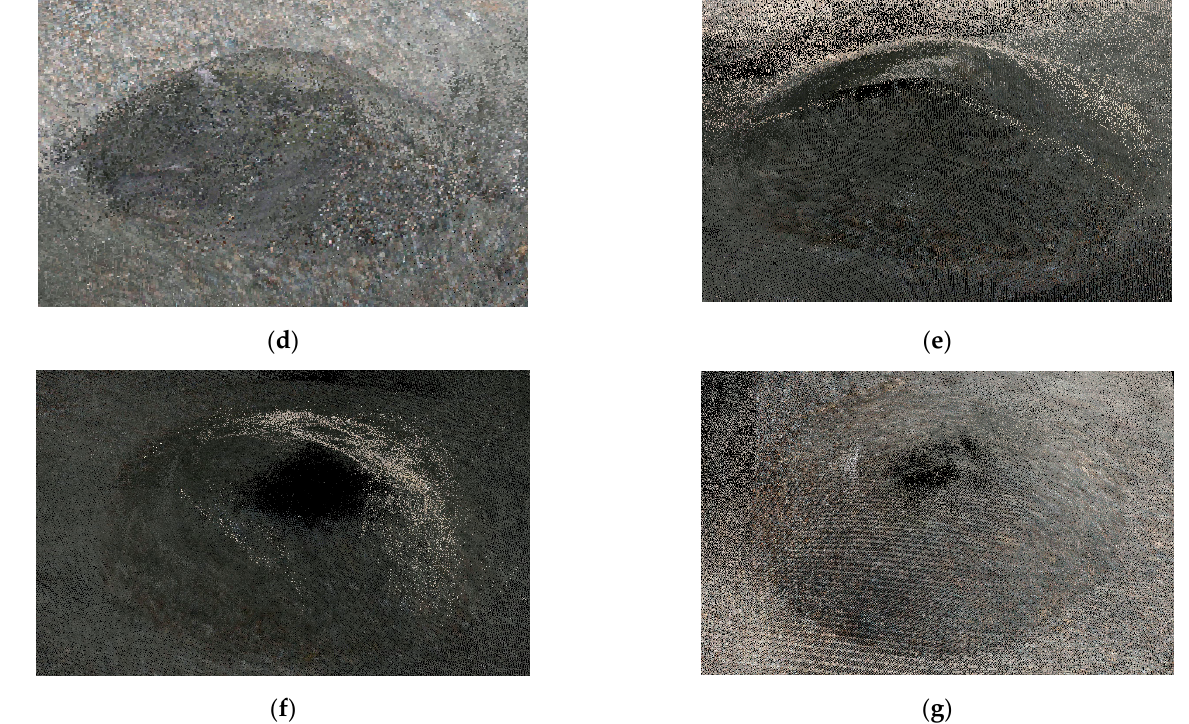
Figure 9. The 3D dense point-clouds of terrain features: ( a ) crater I; ( b ) crater II; ( c ) crater III; ( d ) mound I; ( e ) mound II; ( f ) mound III; ( g ) mound IV.